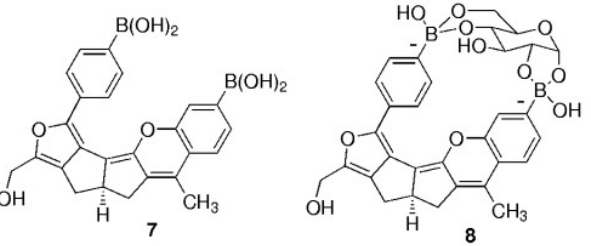
Figure 14. Computational aided designed ligand, based on PBA, for the selective binding to glucose. The molecule 7 correspond to the ligand in its free form, and the molecule 8 corresponds to the ligand-glucose complex. Figure taken from the reference